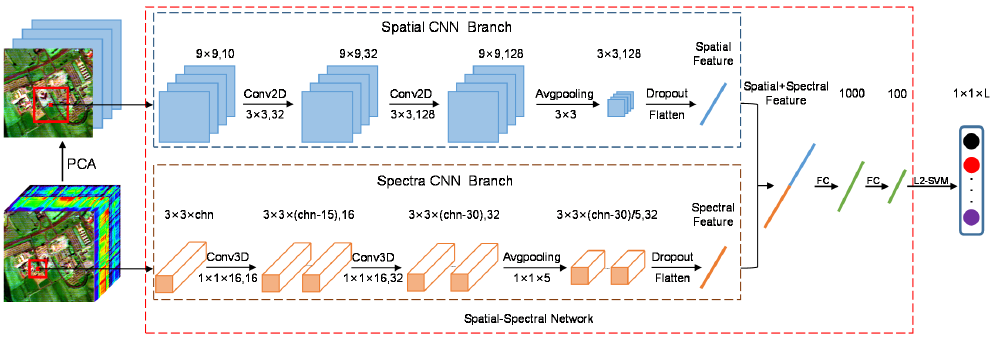
Figure 2. The structure of the Spatial–Spectral Network.